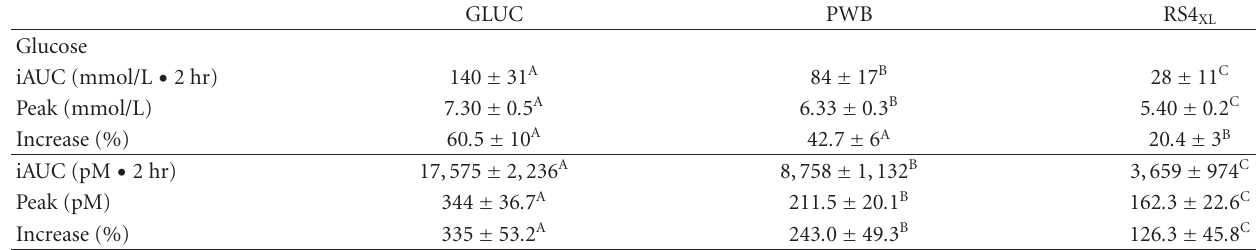
Table 3: Values for the incremental areas under the curves of glucose and insulin concentrations during each trial00. Mean ± SE; di ff erent letters within a row indicates significant di ff erence ( P <